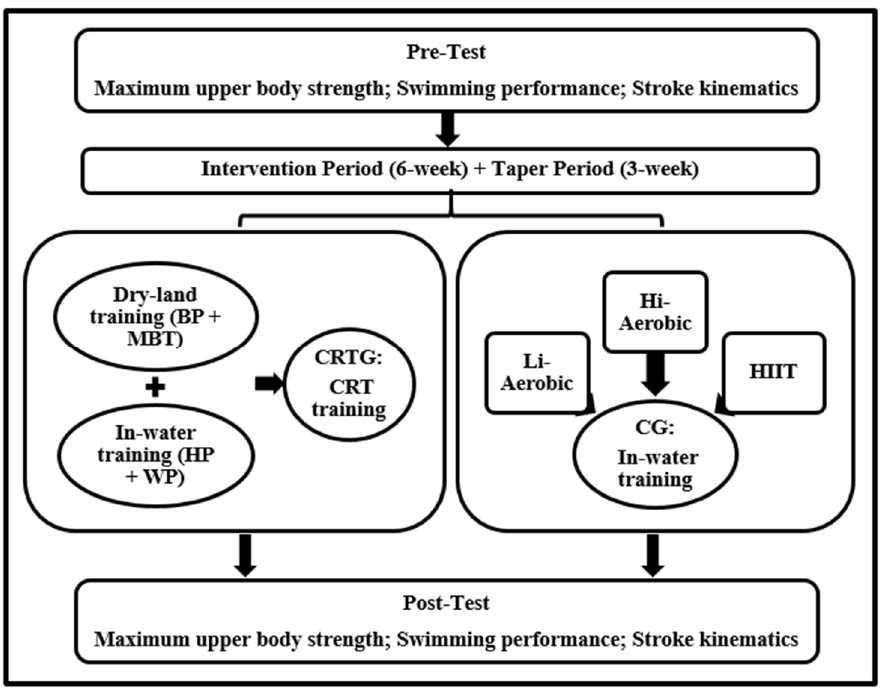
Figure 1. Description of the study design in both groups (CRTG: concurrent resistance training group and CG: control group). BP: bench press, MBT: medicine ball throw, Hi-Aerobic: high-intensity aerobic, Li-Aerobic: low-intensity aerobic and HIIT: high-intensity interval training.